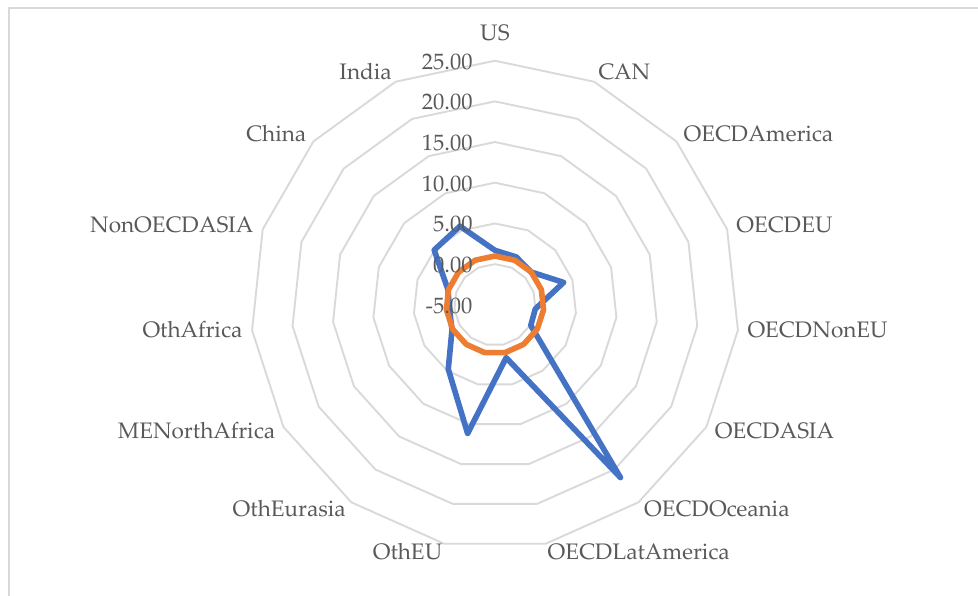
Figure 2. Correlation diagram of the effects of the implementation of the circular economy on the reduction of water pollution caused by microplastics (PWCR vs PLAE).